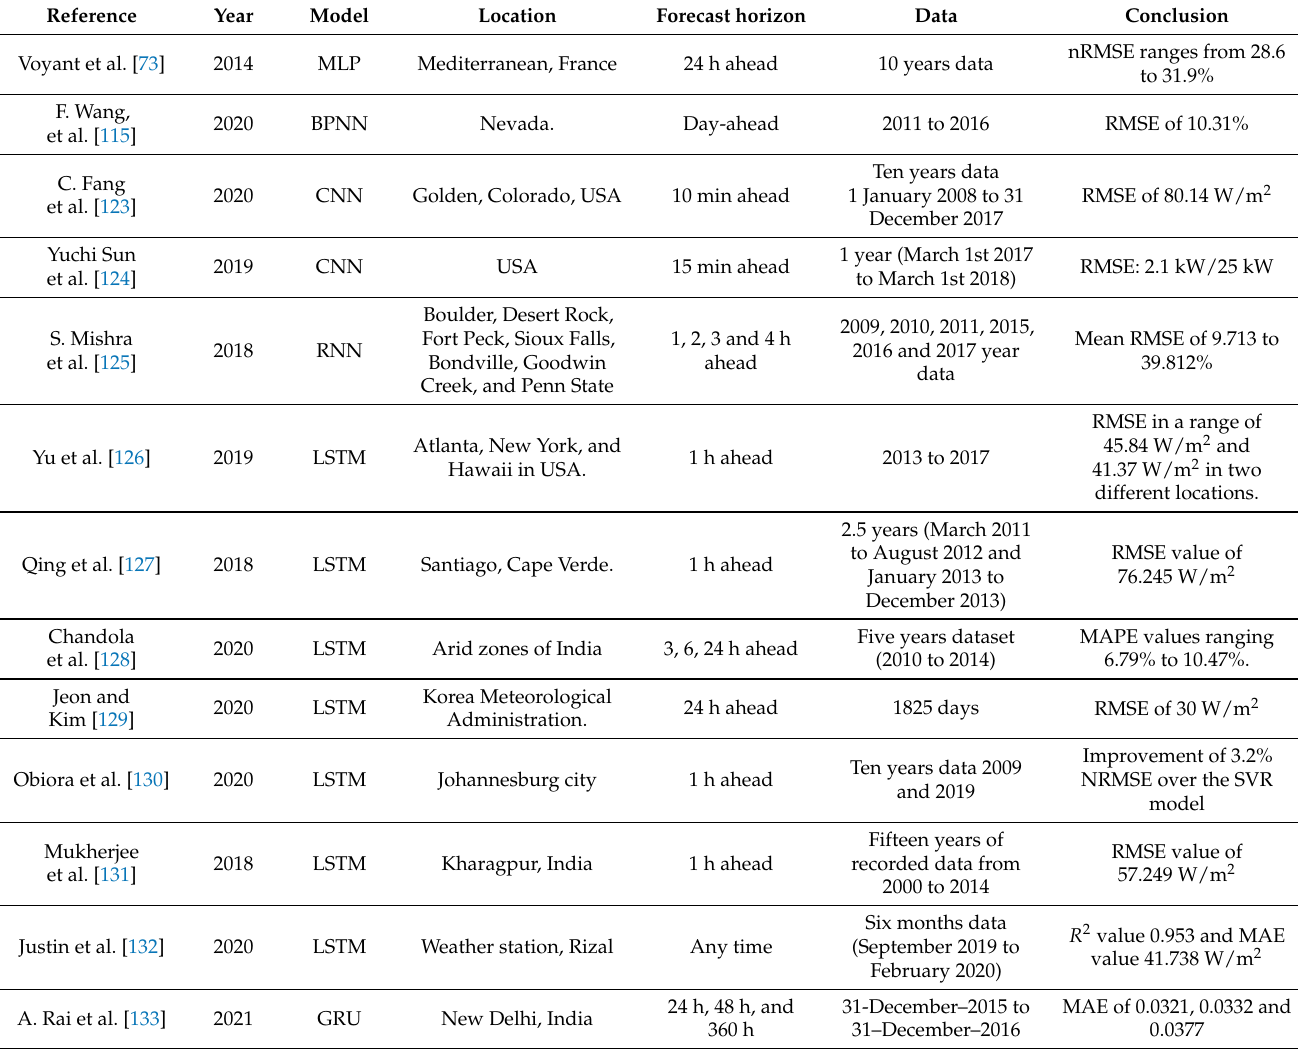
Table 7. Summary of deep learning